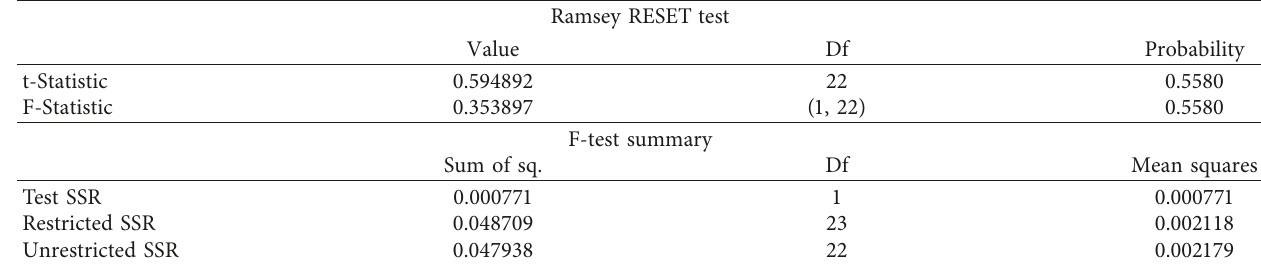
Table 9: Results from the model specification